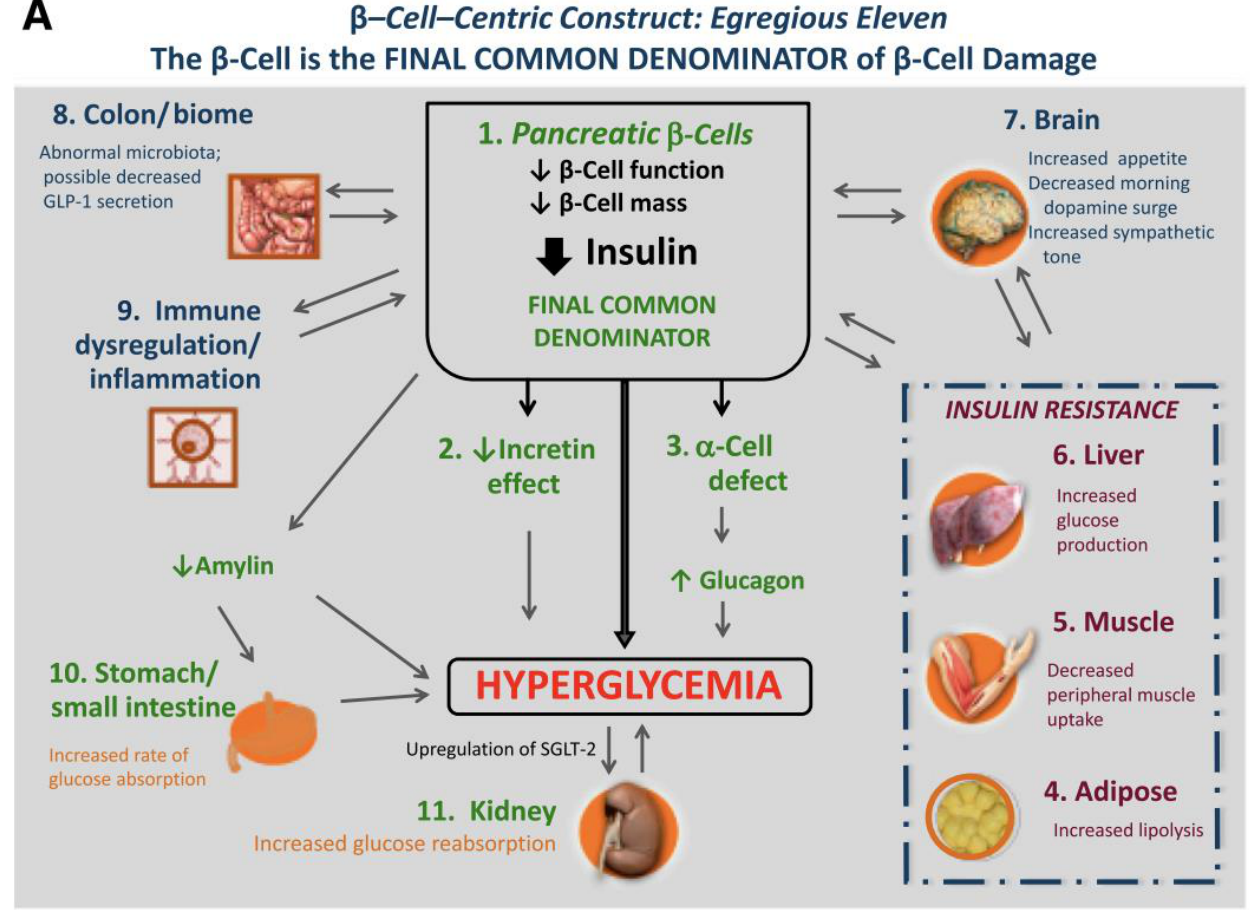
Figure 1. Adapted with permission from Schwartz et al. [12]. The egregious eleven. β -cell–centric construct: the egregious eleven. Dysfunction of the β -cells is the final common denominator in DM. Eleven currently known mediating pathways of hyperglycemia are shown. Many of these contribute to β -cell dysfunction (liver, muscle, adipose tissue (shown in red to depict additional association with IR), brain, colon/biome, and immune dysregulation/inflammation (shown in blue)), and others result from β -cell dysfunction through downstream effects (reduced insulin, decreased incretin effect, α -cell defect, stomach/small intestine via reduced amylin, and kidney (shown in green)).